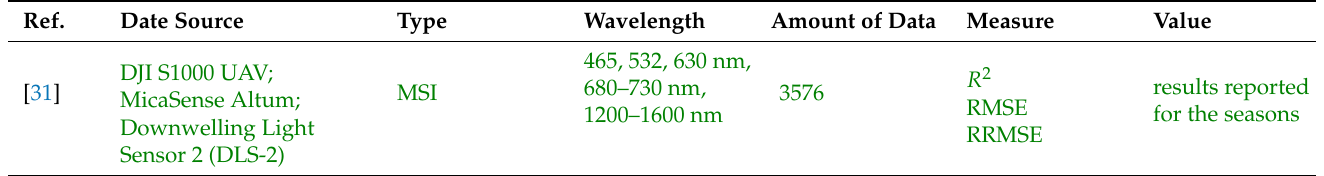
Table 2. The results reported in the selected works on machine learning-powered analysis in various agricultural applications. The papers focusing on the chlorophyll estimation are in green.